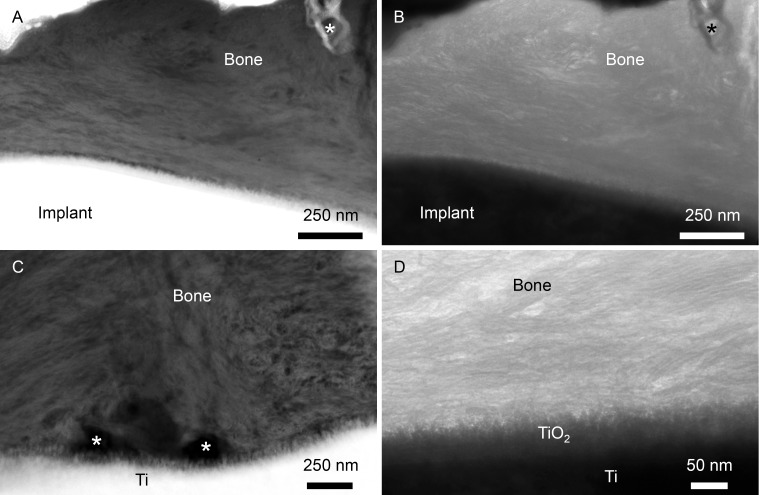
Ultrastructure.(A, C) HAADF-STEM and (B, D) TEM images demonstrating nanoscale interlocking of bone with the laser-modified implant surface. (A-B) Collagen fibrils are aligned parallel to the implant surface and osteocyte canaliculi are observed in close proximity to the implant surface (asterisks). (C) Osteocyte canaliculi appear to make direct contact with the implant surface (asterisks). (D) At high resolution, mineralised collagen fibrils interlock with the nanotextured surface TiO2 layer.